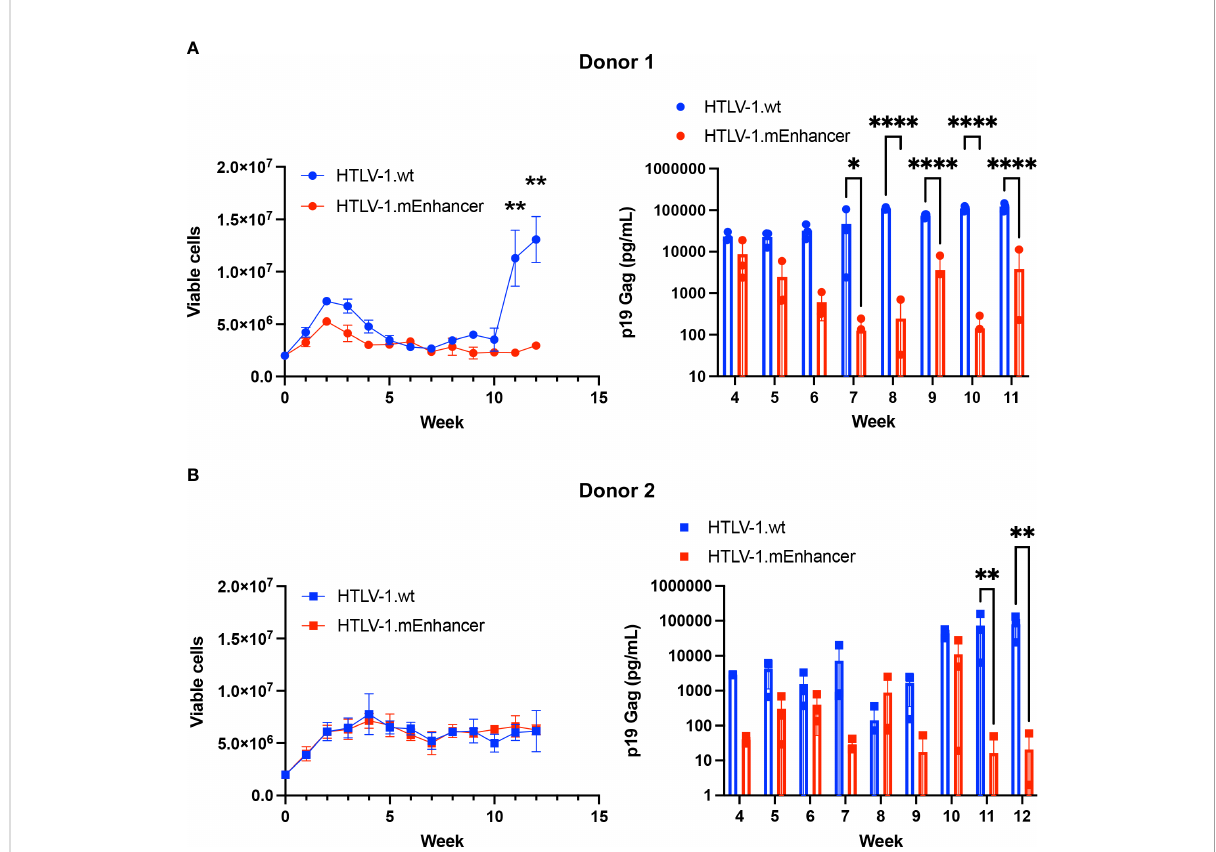
FIGURE 6 HTLV-1.mEnhancer virus immortalizes primary human T-cells in vitro . Freshly isolated human PBMCs (2 x 10 6 ; hPBMCs) from two healthy donors were co-cultured independently with 1 x 10 6 lethally irradiated 729 HTLV-1.wt or HTLV-1.mEnhancer producer cells in 24-well plates for long-term immortalization assay. Cells were supplied with 10 U/mL hIL-2 once per week with media changes. T-cell immortalization in the co- culture with PBMCs from Donor 1 (A) and Donor 2 (B) was determined by weekly viable cell counts by trypan blue exclusion. Cell supernatant was collected at weekly intervals, beginning at Week 4, to measure virion production by p19 Gag ELISA. Samples from Donor 1 are represented by circles, and samples from Donor 2 are represented by squares. Each time point depicts data collected from three random, independent wells (technical replicates), and error bars represent SD. Wells with a p19 Gag value of zero are not shown in the graph due to log transformation. Statistical signi fi cance was determined by unpaired t test and two-way ANOVA with Sidak ’ s multiple comparisons test, where appropriate. *P ≤ 0.05, ** P ≤ 0.01, ****P ≤